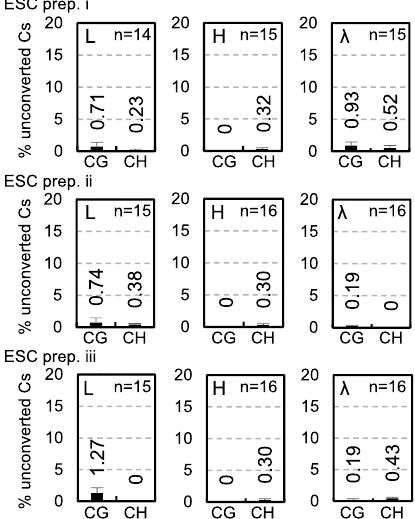
Figure 1. Bisulfite sequencing of cytochrome b gene region of ESC mtDNA. Three independent preparations of embryonic stem cell (ESC) mtDNA (ESC preps. i–iii) were examined by bisulfite sequencing. After bisulfite conversion, L and H strands of the cytochrome b gene region were PCR-amplified and cloned into T-vectors. Average unconversion rates of cytosines at CG sequences (CG) and those at non-CG sequences [CH (H = A, G and T)] in the cloned fragments were obtained from sequencing data for inserts of each plasmid clone, and means of average rates were calculated with SEM for L strands (L) and H strands (H). Data are presented as percentages. A region of control λ DNA − mC was also analysed to confirm conversion efficiency of the reactions ( λ ). n indicates the number of clones analysed in each